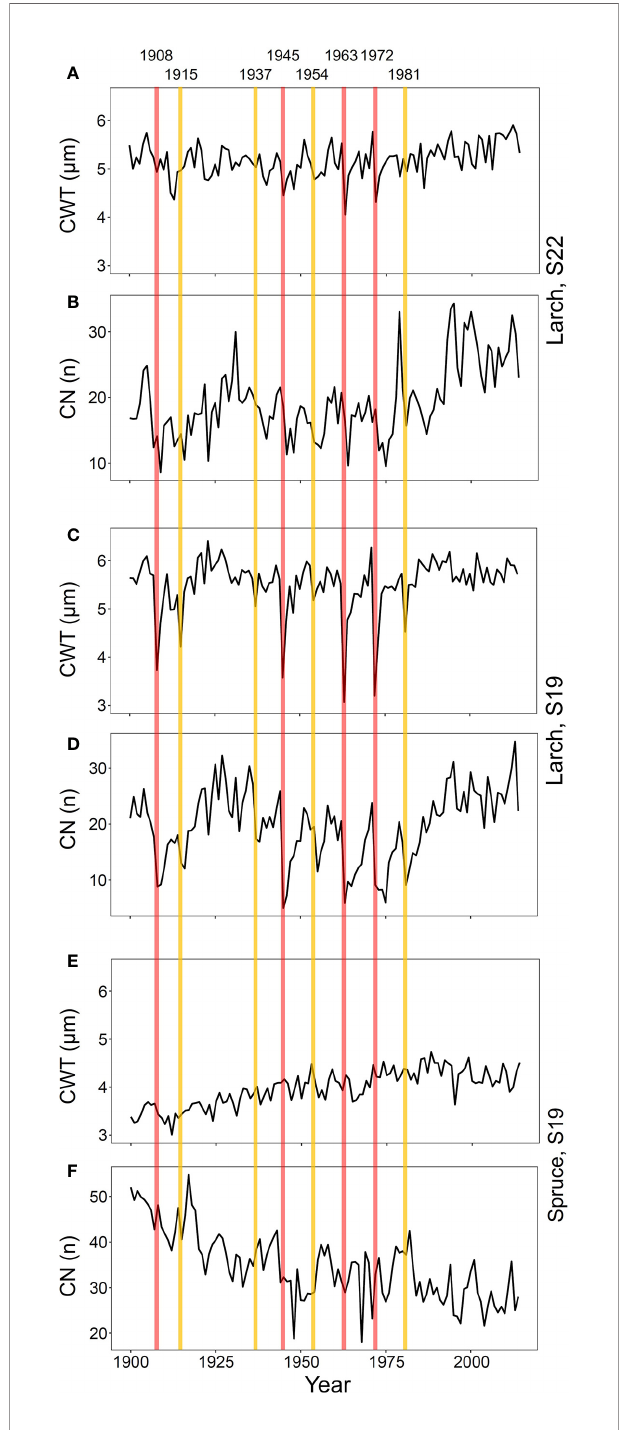
FIGURE 2 | Chronologies of mean-ring cell-wall thickness (CWT, A , C , E ) and cell number (CN, B , D , F ) from 1900 to 2017 for larch at S22 (A , B) and S19 (C , D) and spruce at S19 (E , F) . Vertical lines represent the fi rst years of high- (red) and low- (yellow) severity